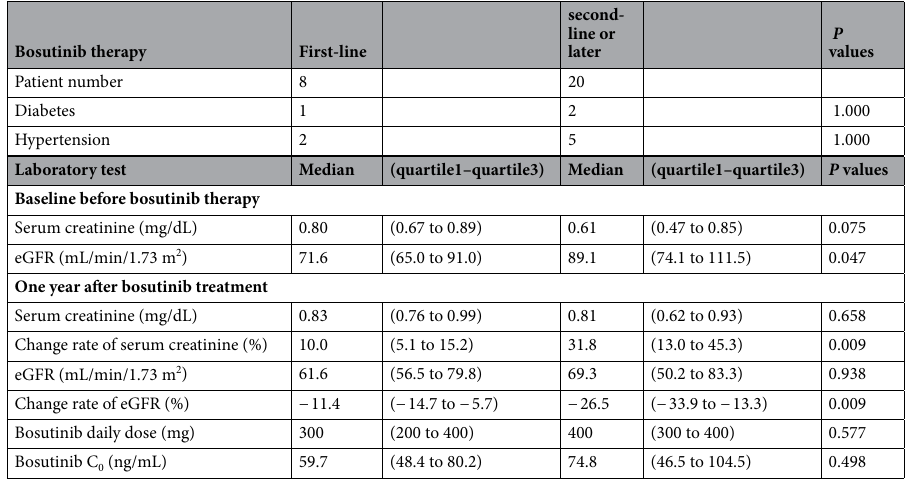
Table 2. Comparison of laboratory test data between patients receiving bosutinib therapy at first-line and second-line or later. C 0 trough plasma